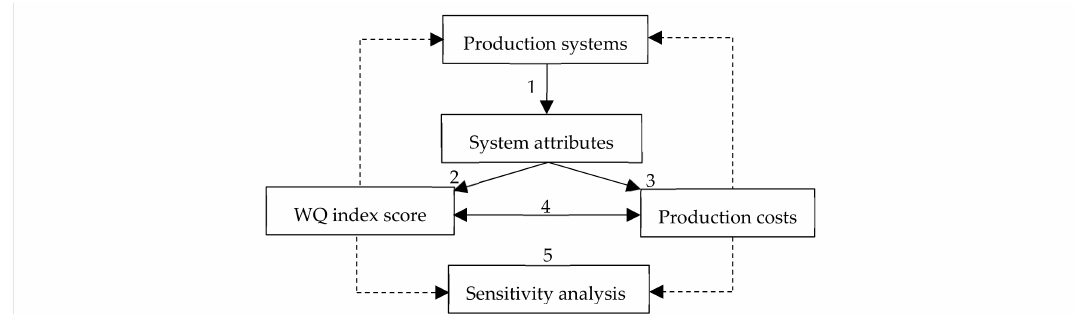
Figure 1. Analysis of approach (obtained from Gocsik et al.